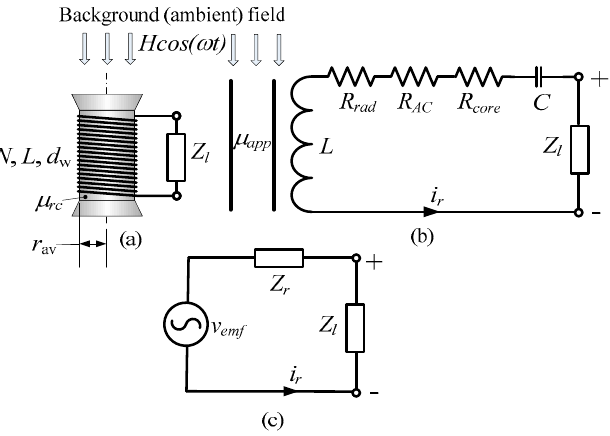
Figure 1. Basic MIEH transducer. ( a ) General view. ( b ) Circuit representation. ( c ) The actual equivalent circuit.